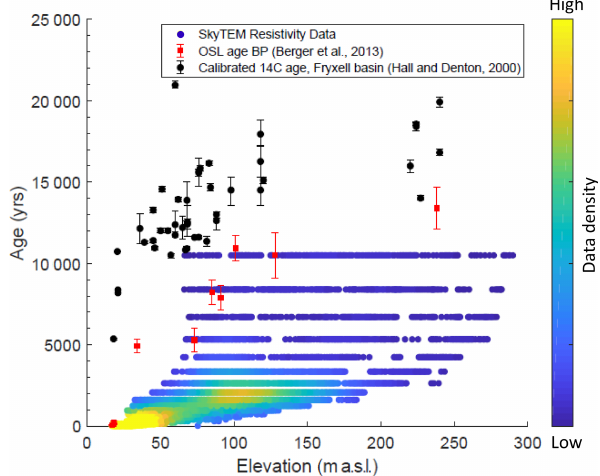
Figure 17. Permafrost ages calculated using the numerical model (Eq. 4) applied to SkyTEM resistivity data. Depth to brine (100 (cid:127) m) was used to calculate permafrost age, assuming a 3 ◦ C/10000 years cooling trend over the Late Holocene. Permafrost ages are colored by data density, where yellows and greens rep- resent higher data density, and blues represent lower data density. Ages are better constrained for younger, shallower permafrost, so ages were cut off at 400m depth to brine (corresponding to per- mafrost ages of ∼ 21000 years BP). 14 C (Hall and Denton, 2000) and OSL (Berger et al., 2013) ages collected from deltas in Lake Fryxell basin are plotted for